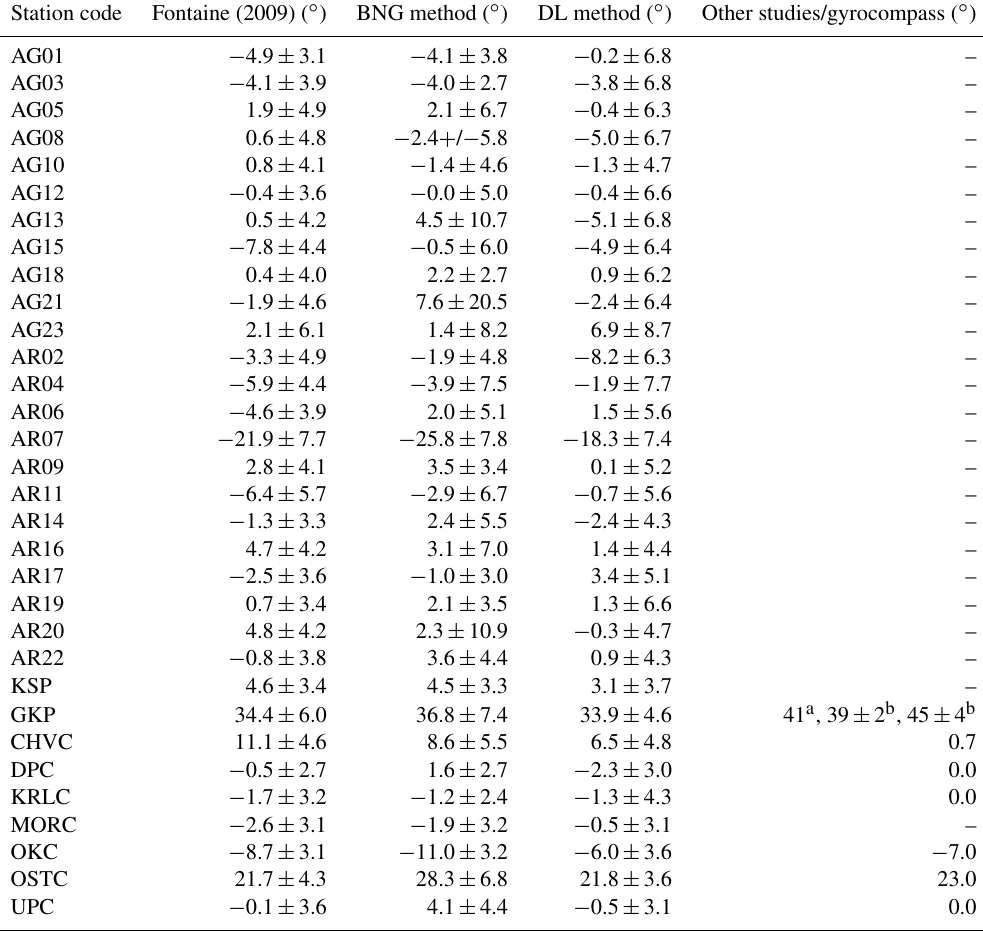
Table 2. Misorientation angles for all stations, obtained by different methods. Last column shows values from high-precision gyrocompass measurements or from other studies (if